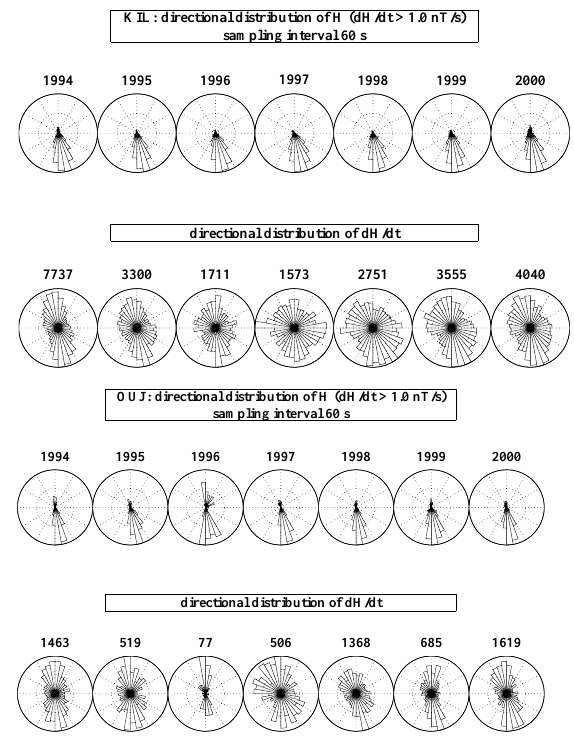
Fig. 4. Directional distribution of ∆ H (upper row) and d H /dt (lower row) at Kilpisj¨arvi (KIL) and Ouluj¨arvi (OUJ) from 1994 to 2000, as calculated from one minute values. Only timesteps fulfill- ing the condition | d H /dt | > 1 nT/s are included. The distribution patterns are normalized separately for each subplot. The total num- ber of timesteps are given as title texts in the lower